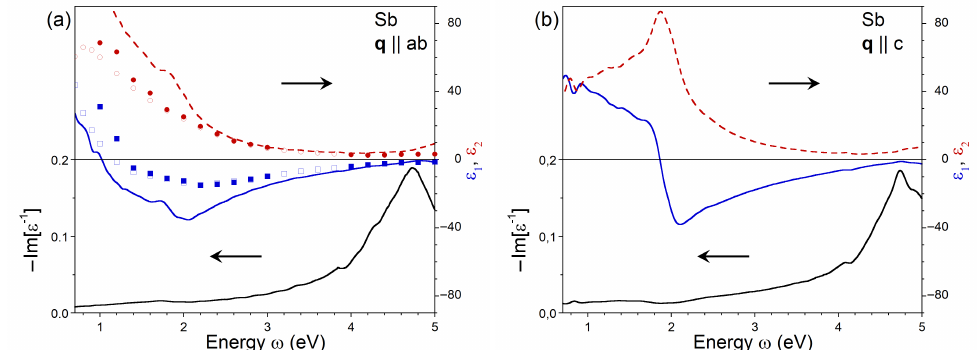
Figure 6. Imaginary (red dashed line) and real (blue solid line) parts of dielectric function in Sb calculated at q pointing in ( a ) ab plane and ( b ) c direction obtained with inclusion of the local-field effects and the ALDA kernel. The respective loss function, − Im [ (cid:101) − 1 ] , is shown by black solid line. The dielectric function components derived from the optical measurements are shown by filled [34] and open [32,33]